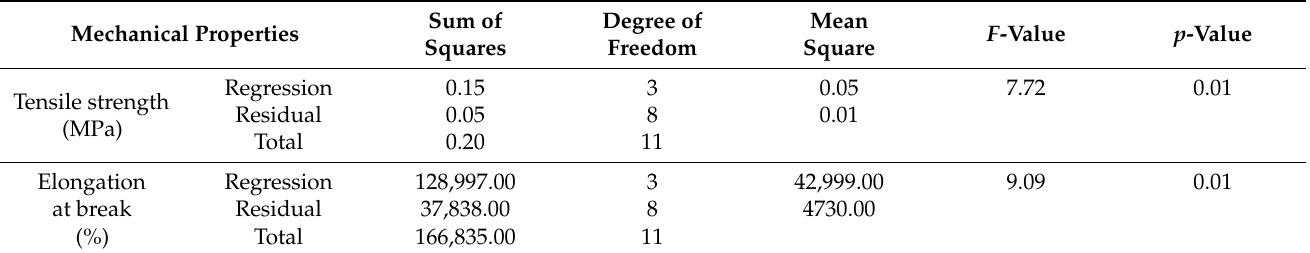
Table 1. ANOVA table of mechanical properties.